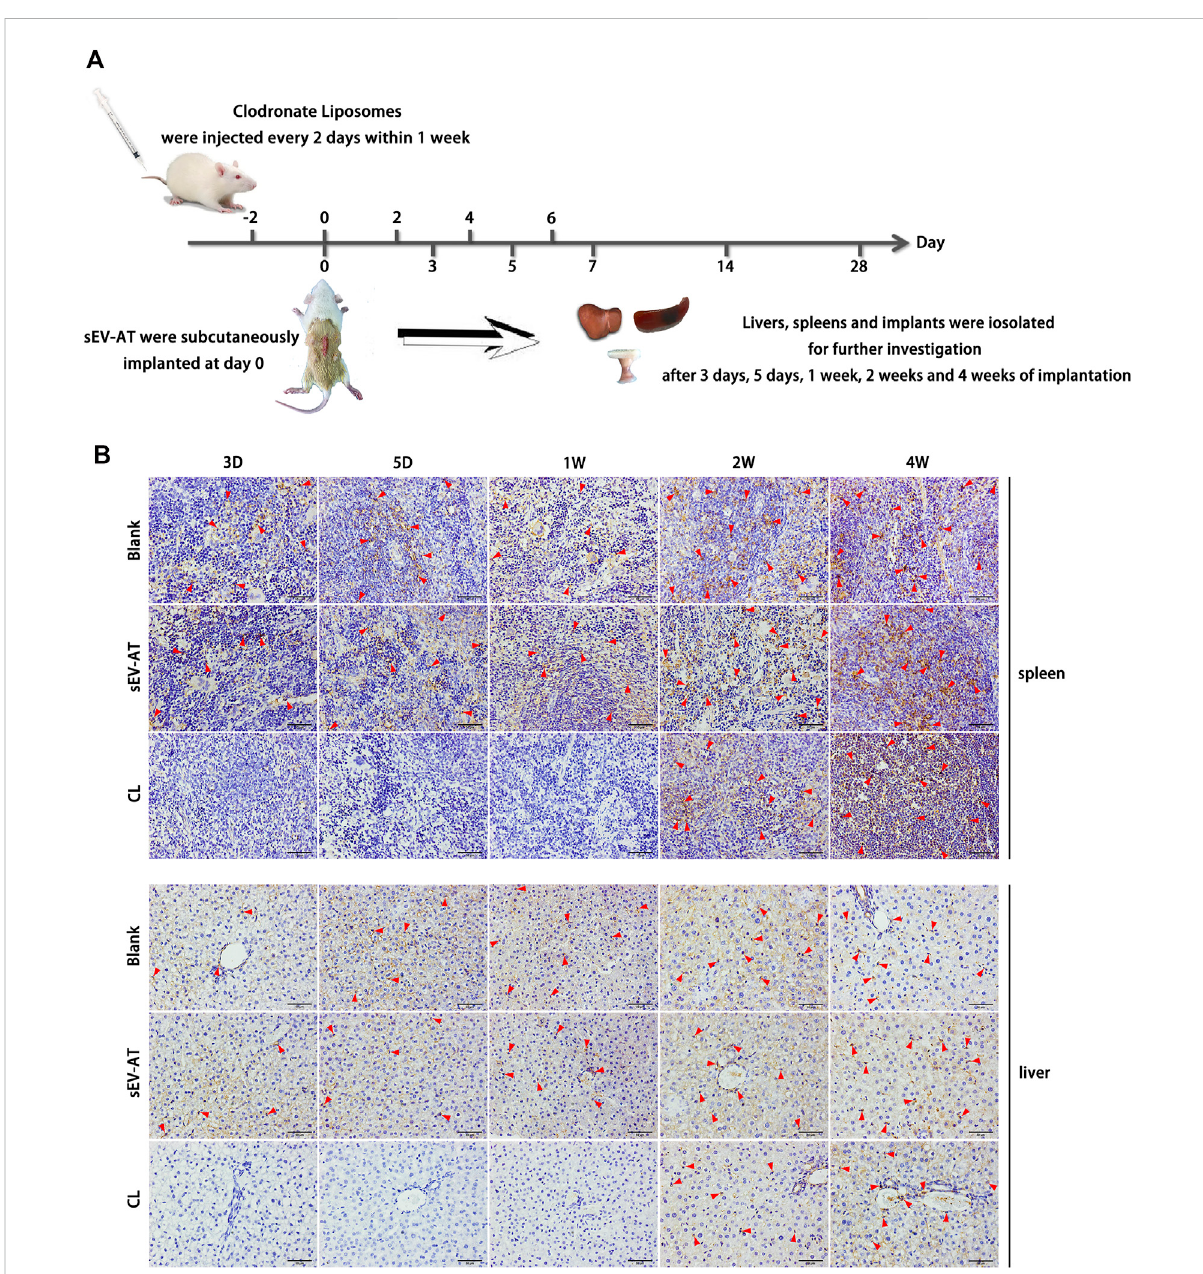
FIGURE 2 Macrophages in the livers and spleens. (A) Clodronate liposome was intravenously injected into each rat in the CL group. After 2 days of injection, sEV-AT mixed with Matrigel was subcutaneously implanted. Clodronate liposome was injected into the rats of the CL group every 2 days within 1 week to maintain the depletion of macrophages. The liver, the spleen, and the implant were isolated for further testing at 3 days, 5 days, 1 week, 2 weeks, and 4 weeks. (B) Representative anti-F4/80 immunohistochemical images of the livers and spleens. The red triangles pointed out typical F4/80 + cells. Scale bar = 50